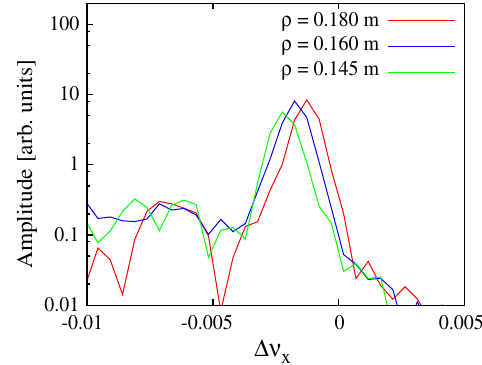
FIG. 18. Simulation results of betatron frequency spectra for choices of the vacuum chamber radius, representing a horizontal betatron tune shift at around 14 ms of the acceleration time.